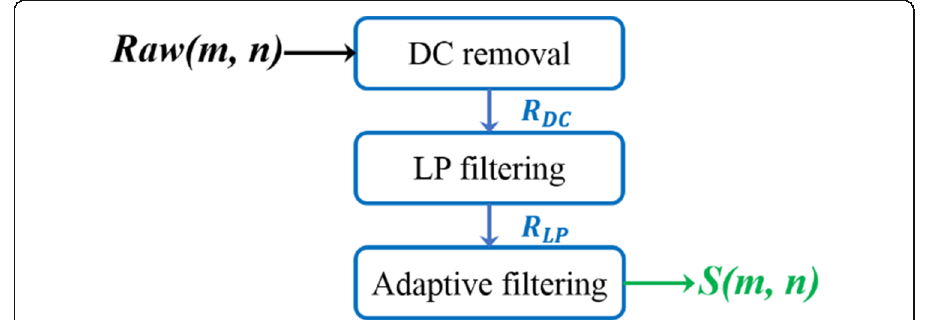
Fig. 2 Flow chart of the signal preprocessing steps. DC, direct current; LP, low-pass